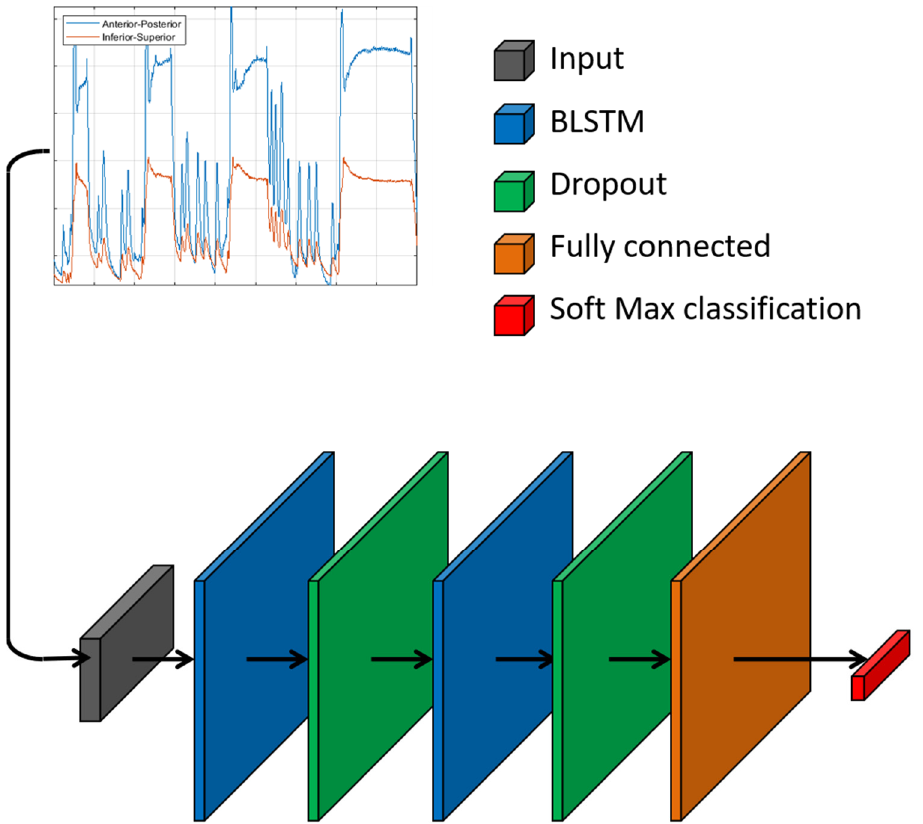
Figure 4. Architecture of the deep neural network for classification of respiratory tracks based on BLSTM units.